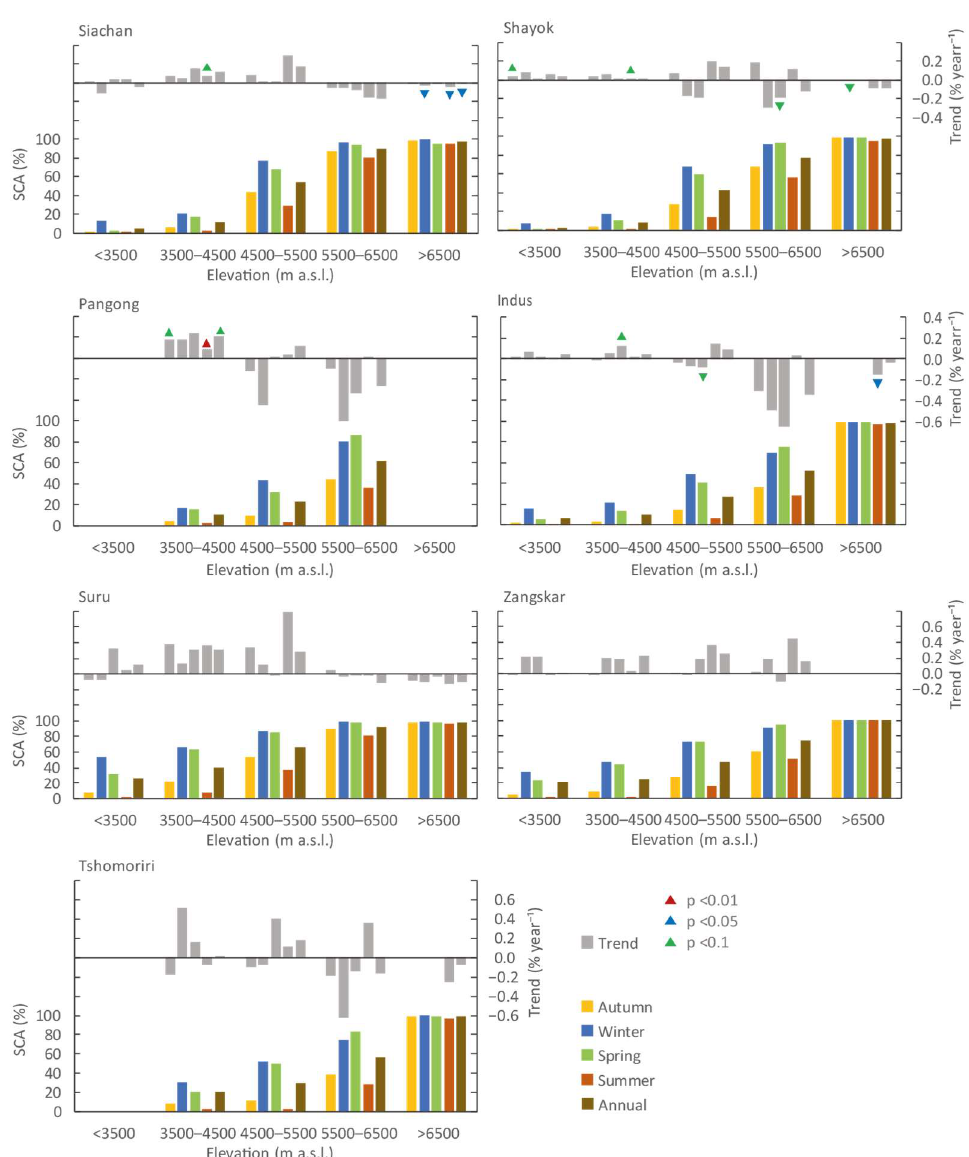
Figure 10. Seasonal and annual MODIS SCA and trends in relation to elevation zones of all subregions of Ladakh for the observation period of 2000–2019. p -value significance levels are shown in red ( p < 0.01), blue ( p < 0.05), and green ( p < 0.1) triangles (see also Table A2). Aspect is another striking feature of snow cover distribution (Figure 11). South- and southwest-facing slopes are less snow-covered than all other slopes, except in the subre- gion of Siachan, where a shift to southwest- and west-facing slopes can be observed. In the subregions of Suru, Siachan, and Zangskar, the negative deviation is most prominent in autumn. In contrast, north- and northwest-facing slopes show the highest positive de- viation in almost all subregions, except for Shayok, where west- and northwest-facing slopes, and for Tshomoriri, where north- and northeast-facing slopes have the largest SCA. In contrast to elevation and aspect, SCA does not show large differences between individual slope classes, except for the Shayok region, where a decrease of SCA with the increasing slope angle can be detected (Figure 12).